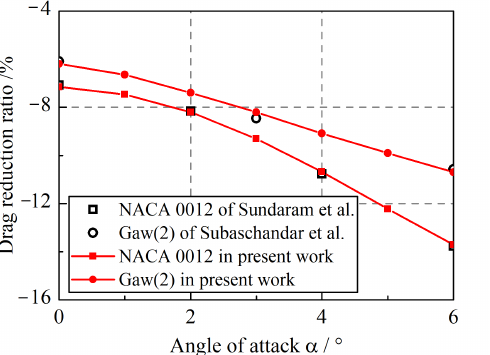
Figure 11. Comparison work of drag-reduction ratio for the flow with pressure gradient.